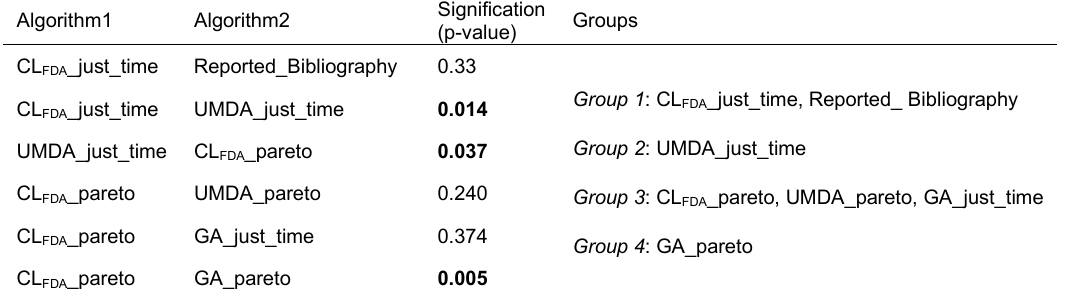
Table 10. Comparison results using Wilcoxon test, variable